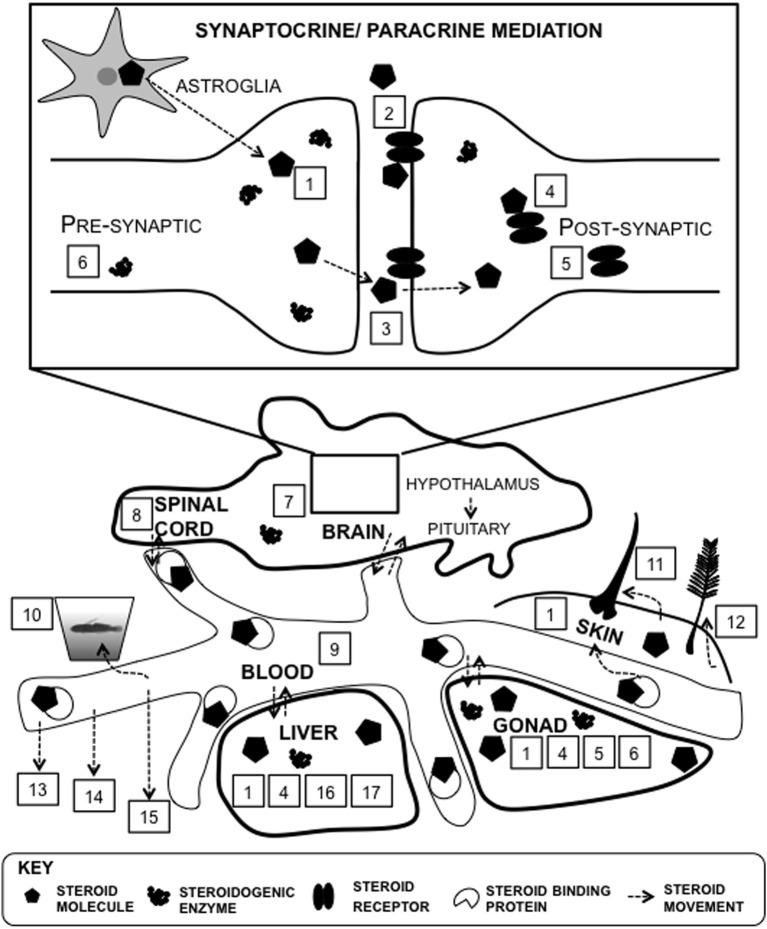
Proxies of steroid function at multiple levels of analysis. There are many different approaches to determine steroid levels in organisms. Steroids can be measured within particular tissues such as the brain, and in systemic circulation, such as plasma. Direct proxies within brain tissue include steroid signaling molecules such as receptors and steroidogenic machinery, such as enzymes (#1–8): 1, tissue; 2, membrane receptor protein; 3, synapse; 4, intracellular receptor protein; 5, steroid receptor mRNA expression; 6, steroidogenic enzyme mRNA expression; 7, steroidogenesis; 8, cerebrospinal fluid. Steroids can be synthesized in astroglia and within the the synaptic bouton (Saldanha et al., 2011). There are many proxies of systemic measures (#9–17): 9, plasma; 10, water-borne; 11, hair/fur; 12, feather; 13, saliva; 14, urine; 15, feces; 16; steroid metabolism; 17, steroid conjugation.